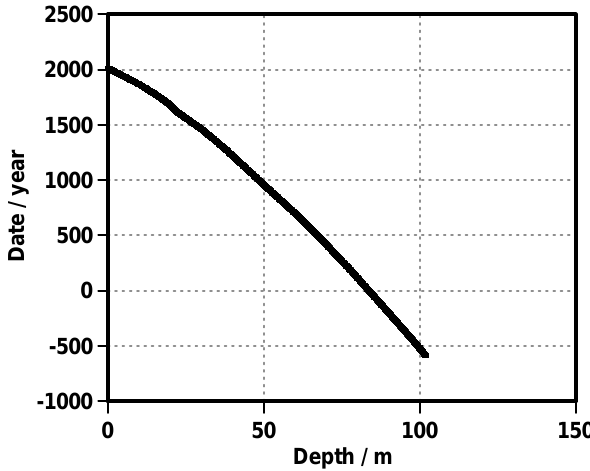
Figure 2. Age vs. depth in core 1 drilled in 2011 CE, Dome C – Antarctica. Dates are given as CE dates, with negative figures indi- cating dates